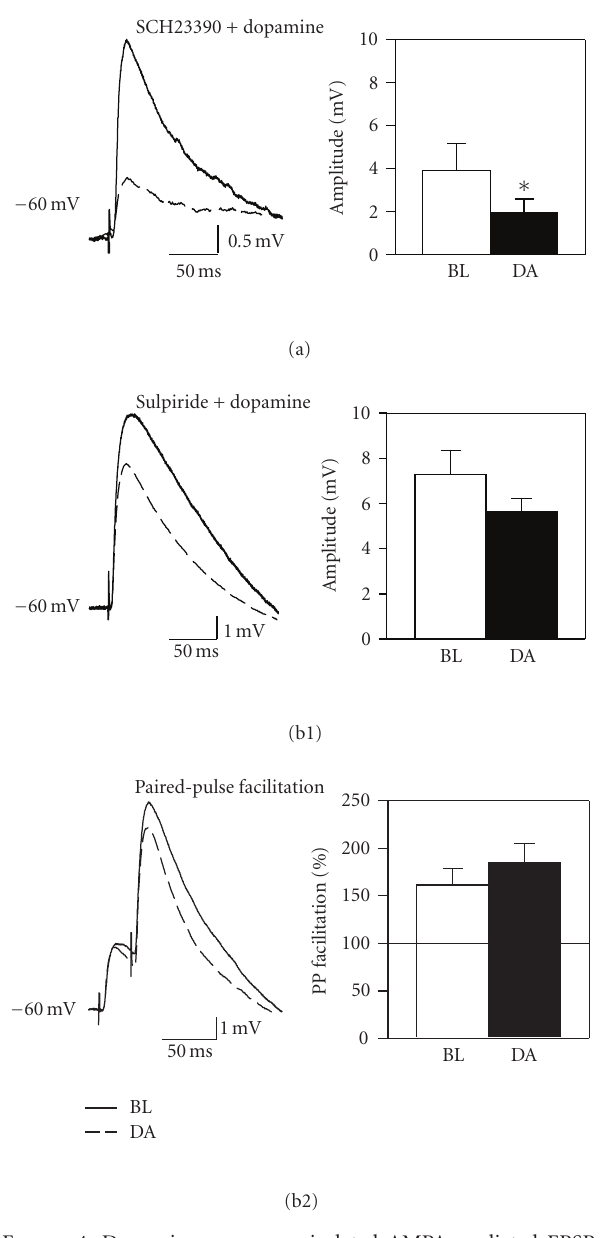
Figure 4: Dopamine suppresses isolated AMPA-mediated EPSPs via a D 2 receptor-dependent mechanism. (a) Coapplication of the D 1 receptor antagonist SCH23390 (50 μ M) did not prevent the dopamine-induced reduction in EPSP amplitude. (b) However, coapplication of the D 2 receptor antagonist sulpiride (50 μ M) significantly attenuated the dopaminergic suppression of EPSPs. Sulpiride also prevented the enhancement of paired-pulse facilita- tion induced by dopamine (b2).